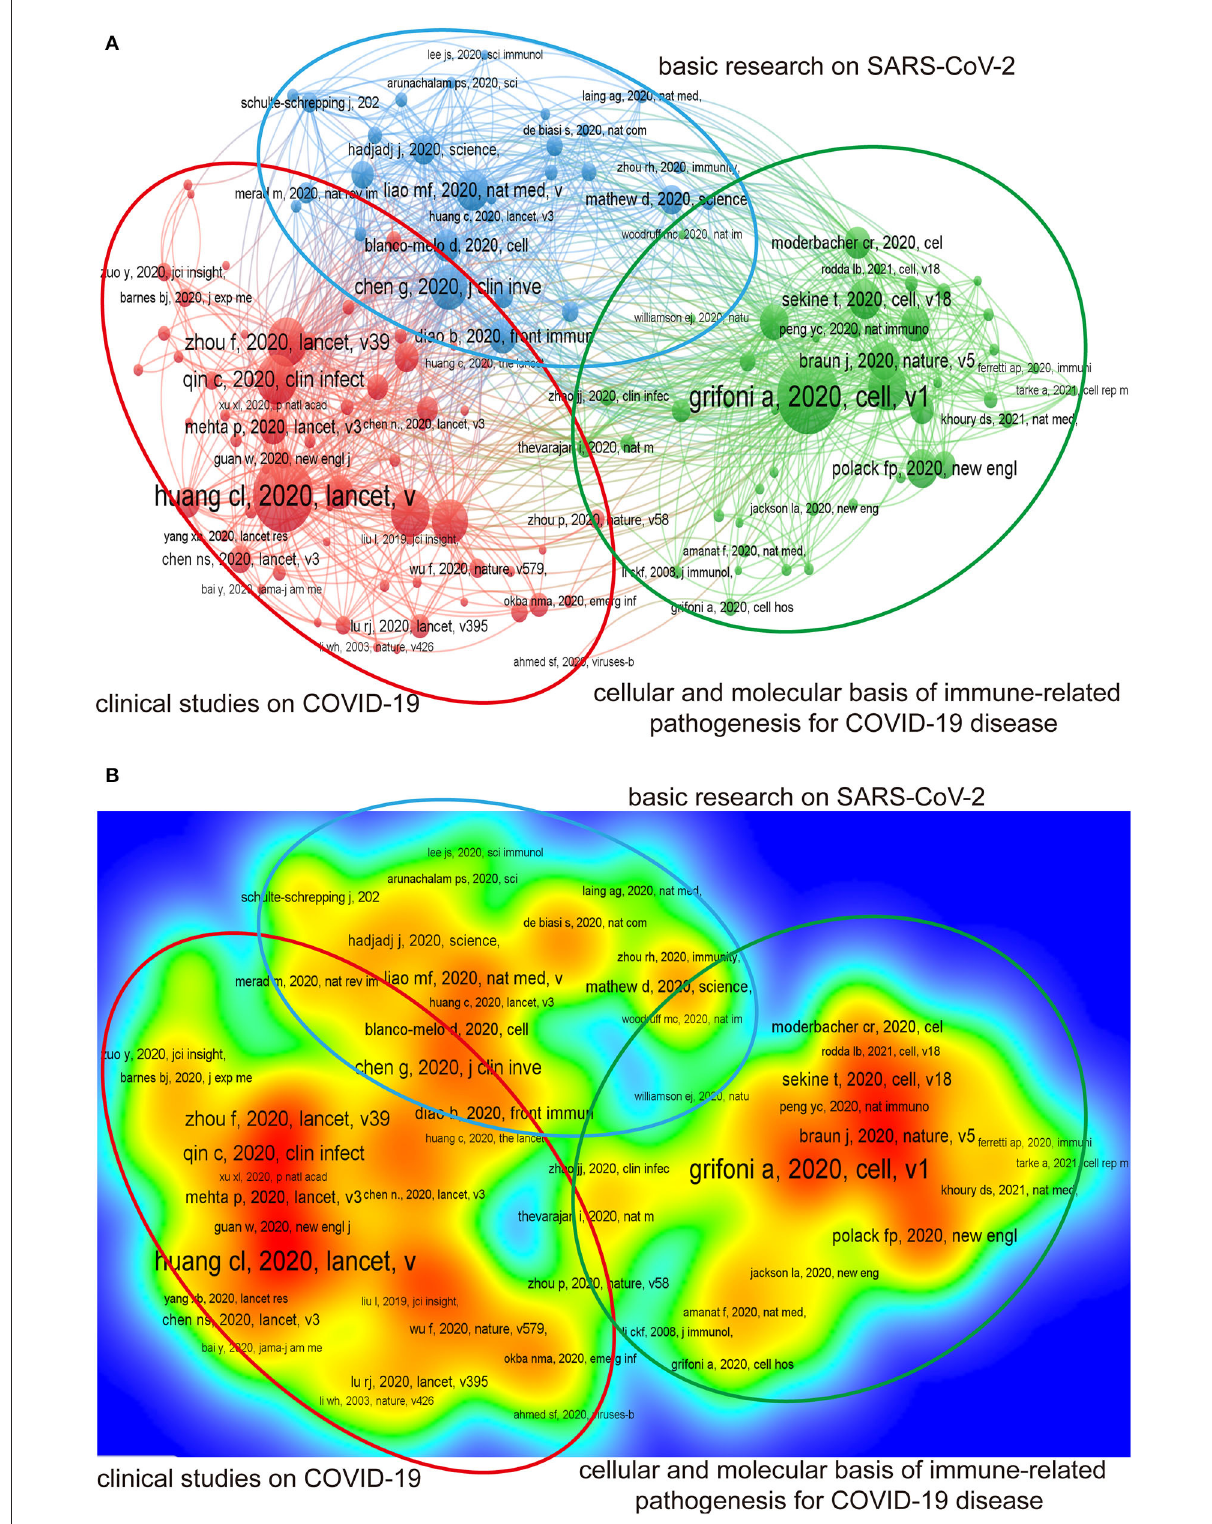
FIGURE5 Cluster analysis plot of references for co-citation. Top 139 articles cited at least 50 times were analyzed by VOSviewer. (A) Each circle in the figure represented a reference of co-citation, and the circle size was proportional to the number of citations. All references were divided into 3 clusters according to their contents: clinical studies on COVID-19 (red), basic research on SARS-CoV-2 (blue), and the cellular and molecular basis of immune-related pathogenesis for COVID-19 disease (green). (B) The thermodynamic chart of references. All references of co-citation were colored difference according to their citations. References with the highest number of citations were marked in